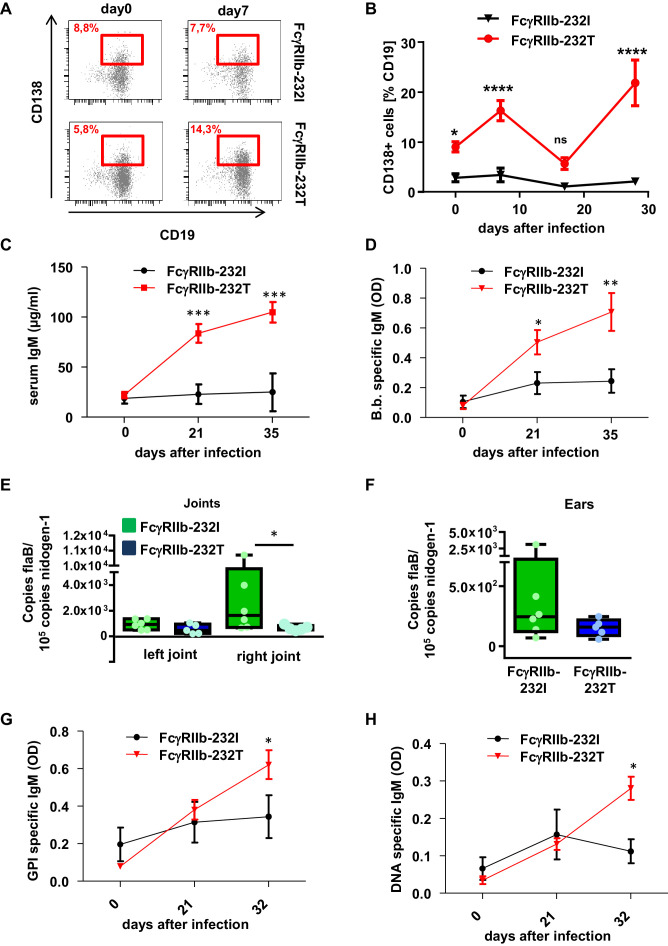
Impact of human FcγRIIb alleles on the humoral immune response and pathogen load during B. burgdorferi infection.(A) Shown are representative dot plots of CD19+CD138+ plasma blasts (marked by red squares including the respective percentage of CD19+CD138+ cells within the population of CD19+ B cells) in the peripheral blood of humanized mice homozygous for the non-functional (FcγRIIb-232T) or functional (FcγRIIb-232I) FcγRIIb allele before and 7 days after infection with B. burgdorferi as detected by flow cytometry. (B) Quantification of the abundance of CD19+CD138+ plasma blasts in the peripheral blood of humanized mice homozygous for the non-functional (FcγRIIb-232T) or functional (FcγRIIb-232I) FcγRIIb allele by FACS analysis at the indicated time points after infection. Shown are mean values +/- SEM of one representative out of two independent experiments with n = 7–12 mice per group. For statistical evaluation, a two-way Anova with a Bonferroni’s multiple comparisons test was used. *p<0.05, ****p<0.0001; ns indicates no significant difference. (C) Quantification of human IgM levels in sera of humanized mice homozygous for functional (FcγRIIb-232I) and non-functional (FcγRIIb-232T) FcγRIIb alleles at the indicated timepoints after B. burgdorferi infection. Shown are mean values +/- SEM of one representative out of two independent experiments with n = 7–12 mice per group. For statistical evaluation, a two-way Anova with a Bonferroni’s multiple comparisons test was used. ***p<0.0005; (D) Shown is the B. burgdorferi specific IgM response (OD) at the indicated time points after infection of humanized mice homozygous for functional (FcγRIIb-232I) and non-functional (FcγRIIb-232T) FcγRIIb alleles. Shown are mean values +/- SEM of one representative out of two independent experiments with n = 7–12 mice per group. For statistical evaluation, a two-way Anova with a Bonferroni’s multiple comparisons test was used. *p<0.05; **p<0.005. (E, F) Quantification of the pathogen load (B. burgdorferi flaB copy numbers normalized to mouse nidogen-1 copy numbers) in ankle joints (left joint, L; right joint, (R) (E) and ears (F) of infected humanized mice homozygous for the functional FcγRIIb-232I (232I) or non-functional FcγRIIb-232T (232T) allele by quantitative PCR 35 days after infection with B. burgdorferi. n = 5–6 mice per group. A two-way Anova test was used to evaluate statistical significance. *p<0.05. (G, H) Detection of glucose 6-phosphate isomerase (GPI) (G) and DNA-specific (H) human IgM responses during the course of B. burgdorferi infection in humanized mice homozygous for the functional (FcγRIIb-232I) or non-functional (FcγRIIb-232T) FcγRIIb alleles. Shown are mean values +/- SEM of one representative out of two independent experiments with n = 7–12 mice per group. For statistical evaluation a two way Anova with a Bonferroni’s multiple comparisons test was used. *p<0.05.